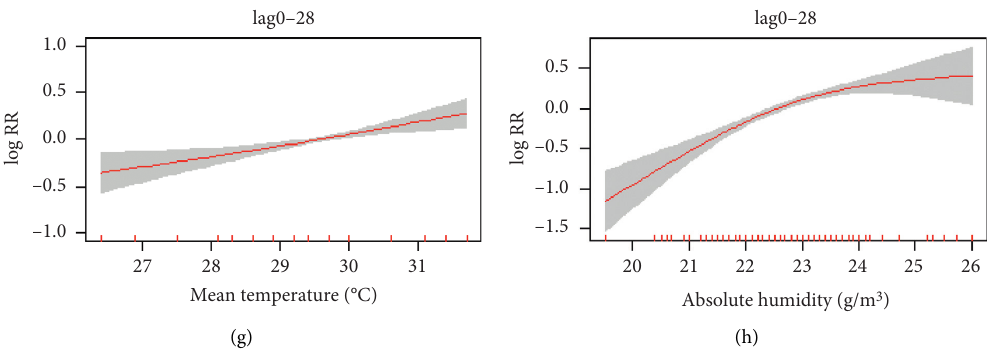
Figure 3: Theexposure-response curvesfor theeffectsof temperatureand absolute humidity onnew dailyCOVID-19 infection.The x -axesare the mean temperature and absolute humidity for 7-day, 14-day, 21-day, and 28-day moving average. The y -axes indicate relative risk ratio Table 3: The effects of 1 ° C and 1g/m 3 increases in mean temperature and absolute humidity on new daily COVID-19 infection. Lag Percent change in temperature (%)